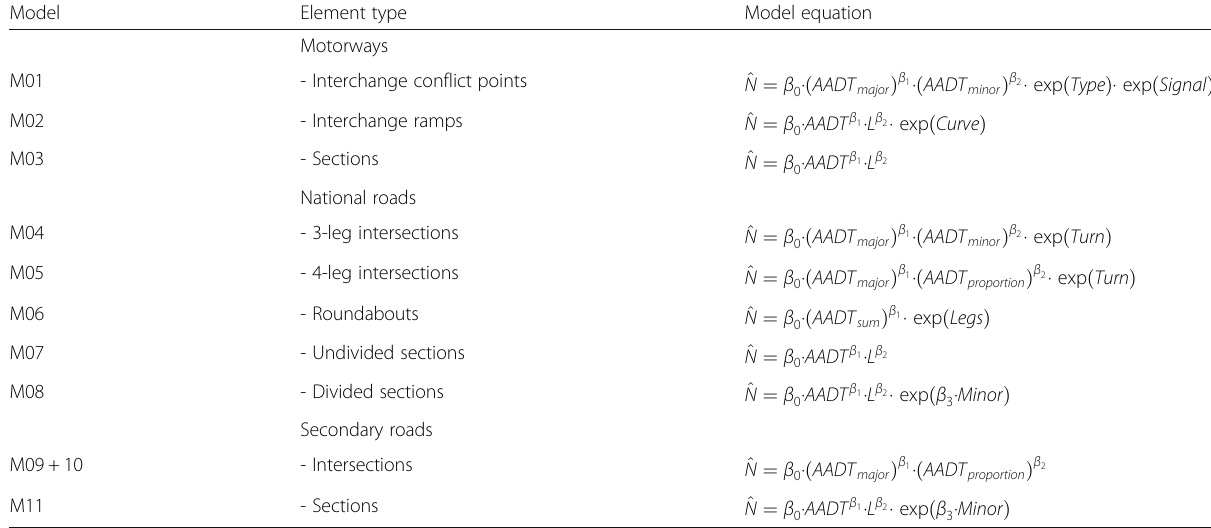
Table 4 Overview of final accident prediction model forms